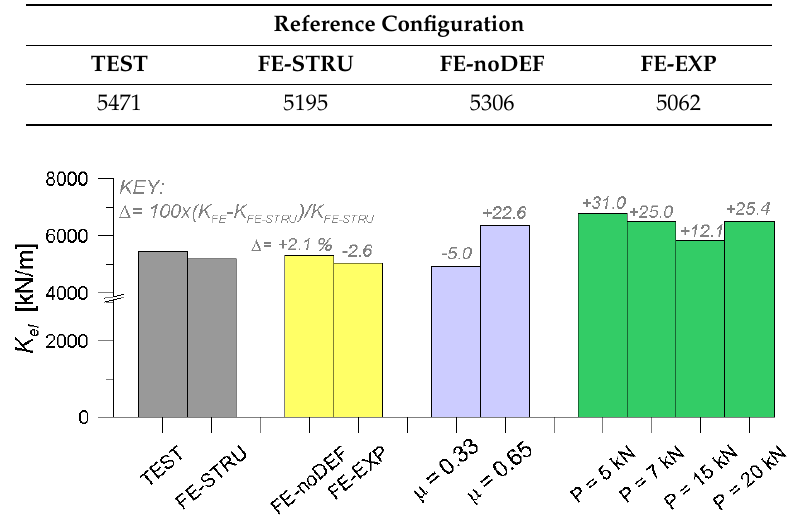
Figure 9. Variation of the K el stiffness for Standard joints, as a function of friction coefficient and preload (ABAQUS).